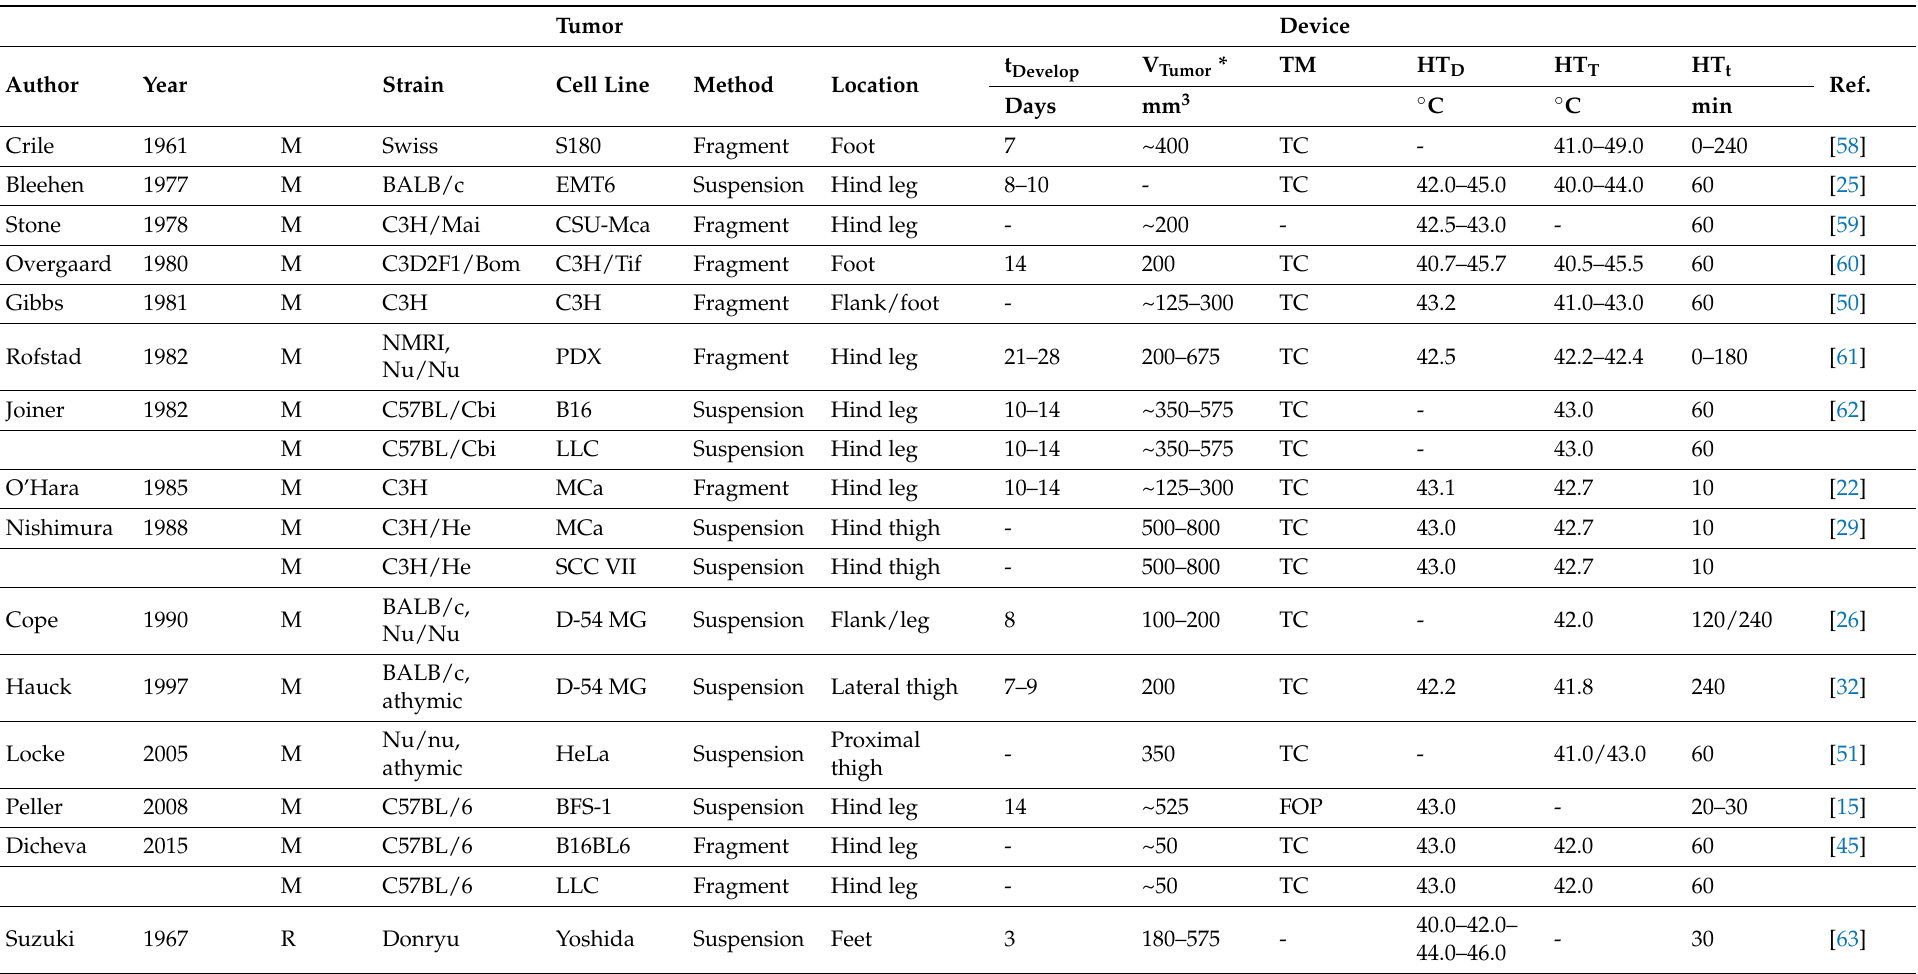
Table 1. Overview of the preclinical studies on application of local hyperthermia using a temperature-controlled water bath sorted by year of publication and animal model. Tumor